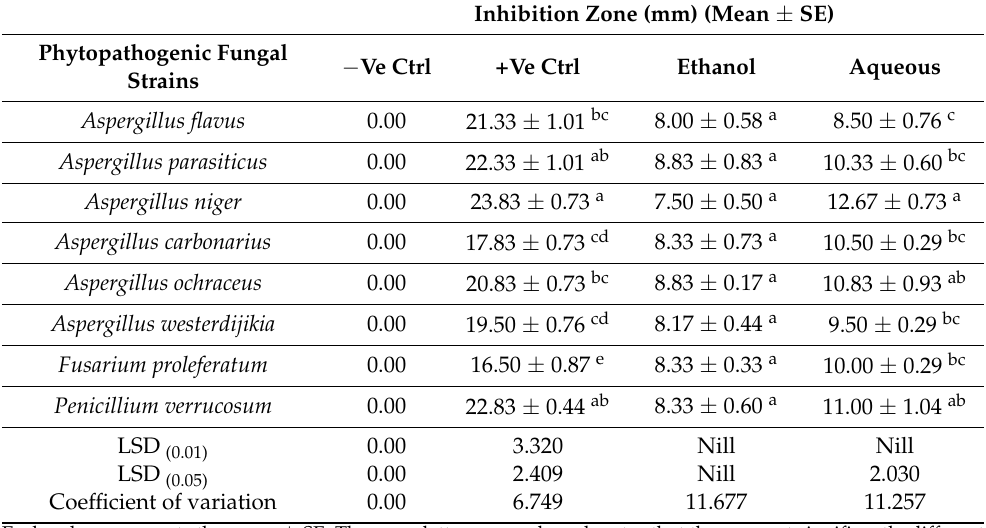
Table 5. Antifungal activity of Moringa ethanolic and aqueous extracts against different fungal strains by disc diffusion